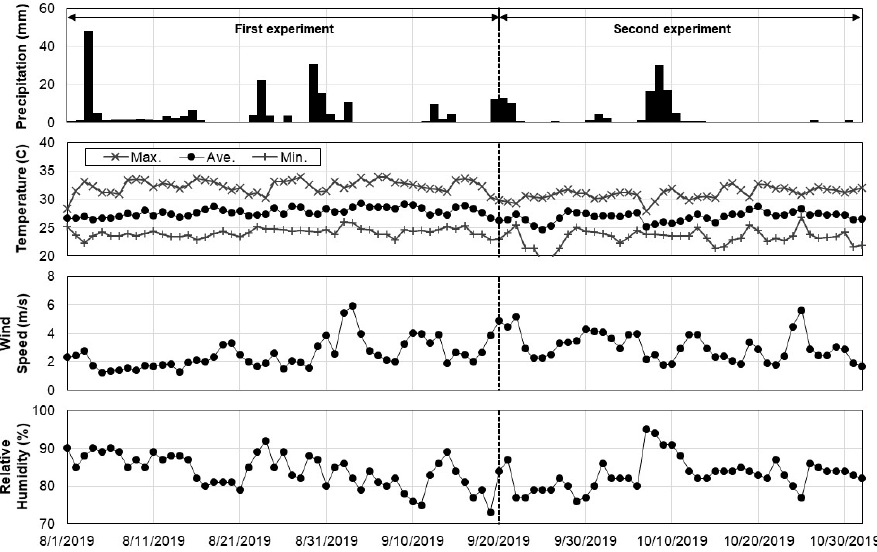
Figure 8. Daily time-series of precipitation, temperature, wind speed, and relative humidity. A multi-spectral sensor (Survey 3W Camera RGN: MAPIR Inc., San Diego, CA, USA) was deployed at a 3.2-m height above the ground to capture the spectral characteristics of the plants’ leaves directly exposed to the sensor. Thus, changes in the numbers and densities of leaves under the surface leaf layers might not be detected by the spectral sensor.